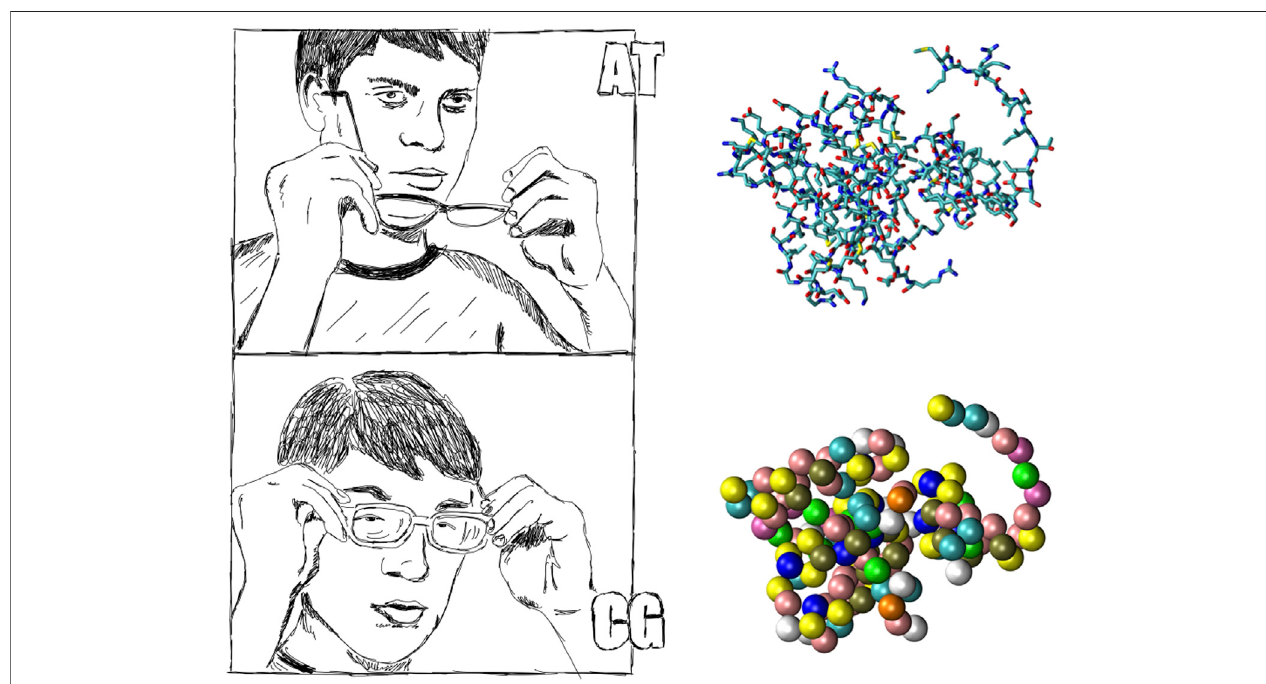
FIGURE 3 | The process of fi ltering is akin to wearing a pair of spectacles while enjoying a perfect eyesight. The loss of detail is generally considered a defect, however it does have the advantage of simplicity and parsimony - if it is done properly. Artwork by R. Potestio.